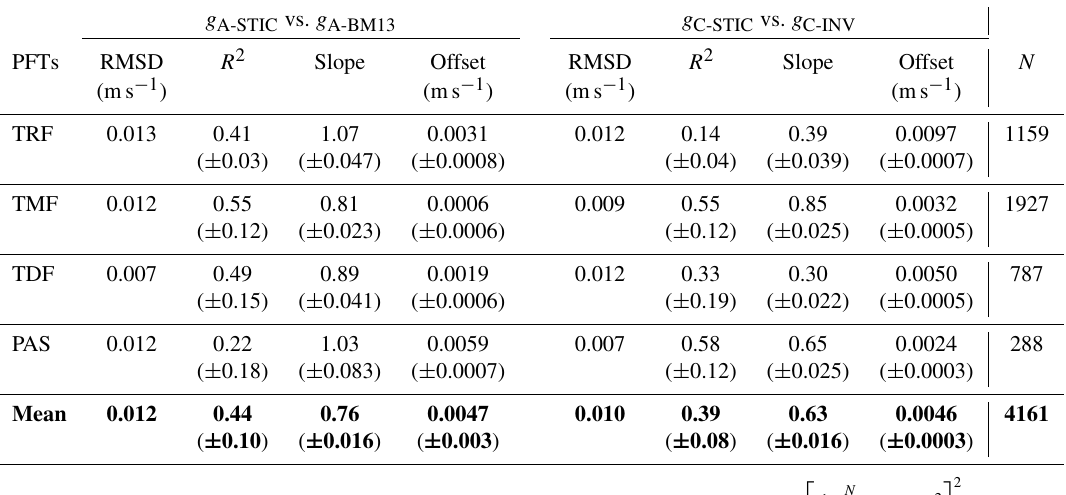
Table 3. Comparative statistics for the STIC- and tower-derived hourly g A and g C for a range of PFTs in the Amazon Basin (LBA tower sites). Values in parentheses are ± 1 standard deviation (standard error for correlation).